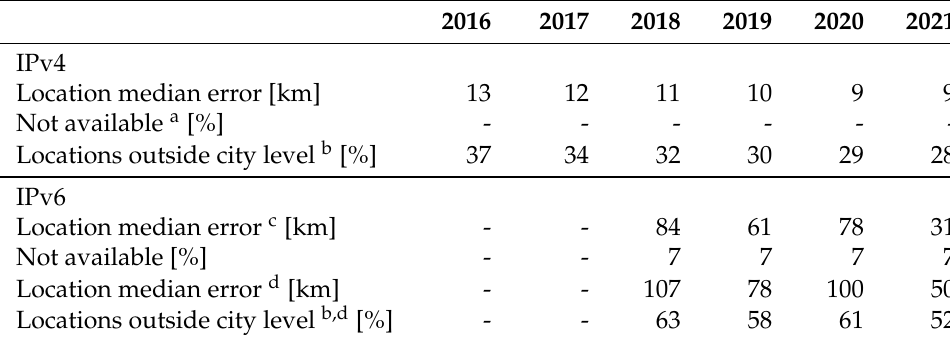
Figure 7. Past location of IPv4 addresses over the years. The dashed lines highlight the location error median and the percentage of locations outside the city level. Table 3. Past location of IPv4 and IPv6